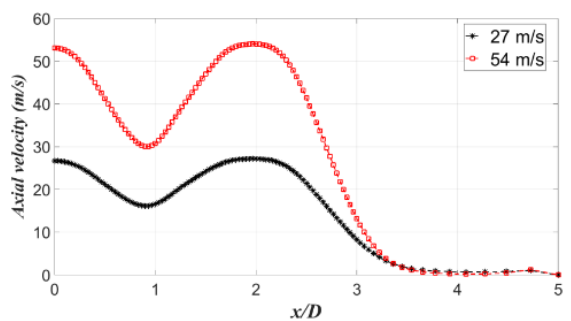
Figure 17. Axial velocity distributions at varied jet inlet velocities (z/D = 5).